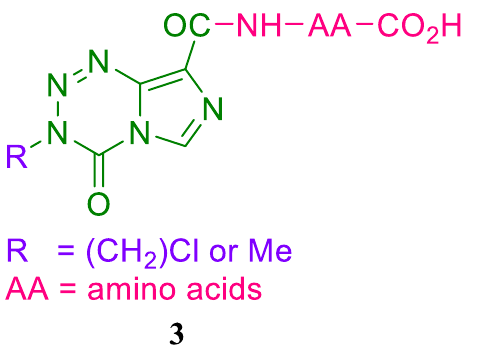
Figure 13. Amino acids/peptides-temozolomide and mitozolomide hybrid molecules. May B C H et al. synthesised α -methylene tetrazole-based peptidomimetics ( 4 ) con-